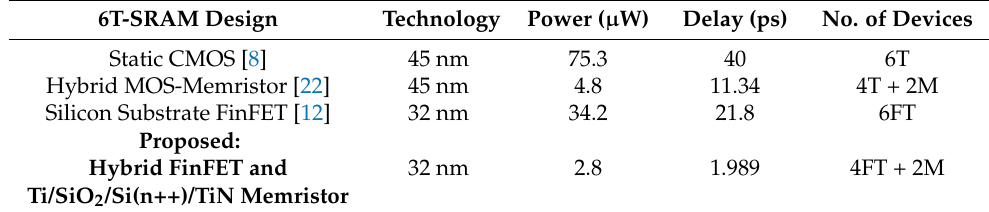
Table 1. Comparison of Power, Delay and Area for various SRAM